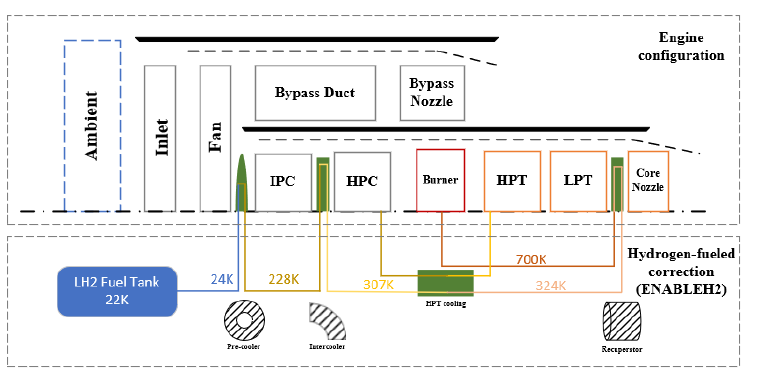
Figure 1. Configuration of hydrogen-fueled turbofan engine proposed by European ENABLEH2 project [1].